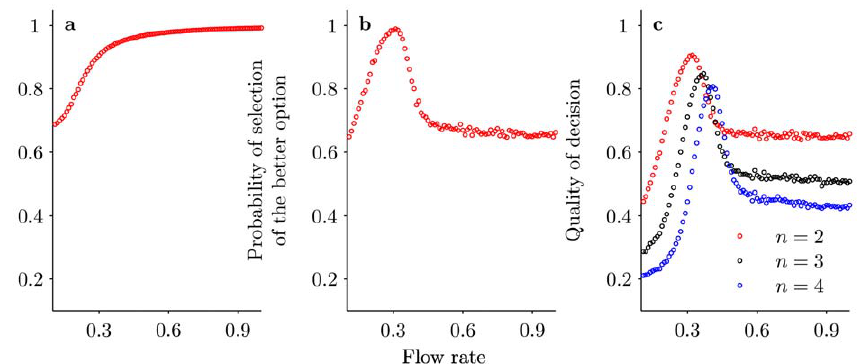
Figure 2. Quantitative view of the quality of decision as a function of the flow rate w as obtained by Monte Carlo simulations. (a) Mean level of commitment for the better option 1 , (b) Probability of selection of the better option and (c) Quality of decision for three different numbers of options. Parameter values as in Fig. 1, number of realizations is 5000.